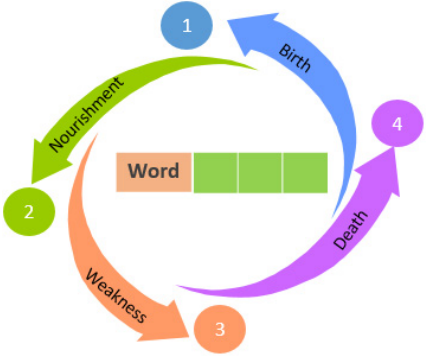
Fig. 2. Life cycle of a